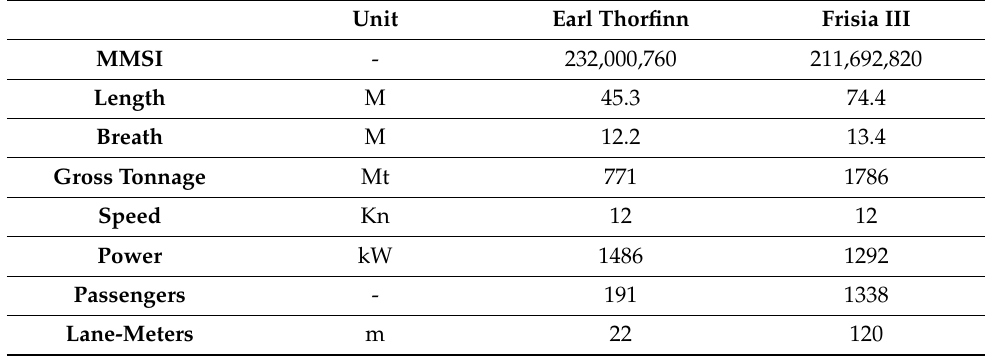
Table 2. Ship technical data for the two case study vessels, including Maritime Mobile Service Identifier (MMSI) and basic